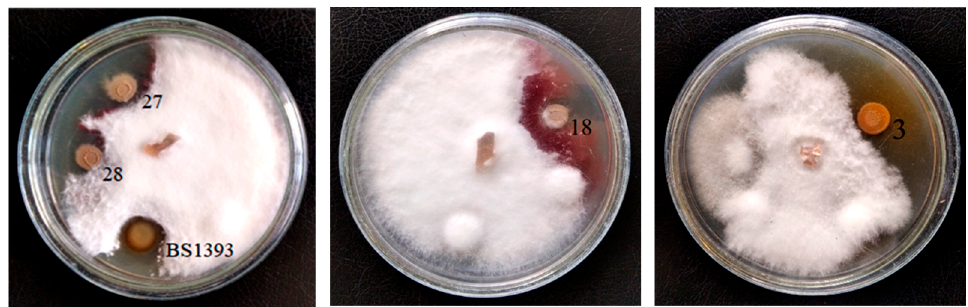
Figure 1. Antifungal activity of the soil strains 3, 18, 27 and 28 towards Fusarium graminearum. Further, these strains (3, 18, 27 and 28) were studied for their ability to inhibit the growth of the phytopathogenic bacteria belonging to the genera Pseudomonas , Pantoea , Ral- stonia , Pectobacterium , Xanthomonas , Agrobacterium and Clavibacter . Strain 3 exhibited the highest antibacterial activity and effectively suppressed nine out of 10 test bacteria (Table 2 and Figure 2). The diameter of the growth inhibition zones, as a rule, was larger than that of the control strain P. chlororaphis BS1393. A significant difference between strains 3 and 1393 was found in the suppression of phytopathogenic bacteria Ralstonia sp. 7-1, X.